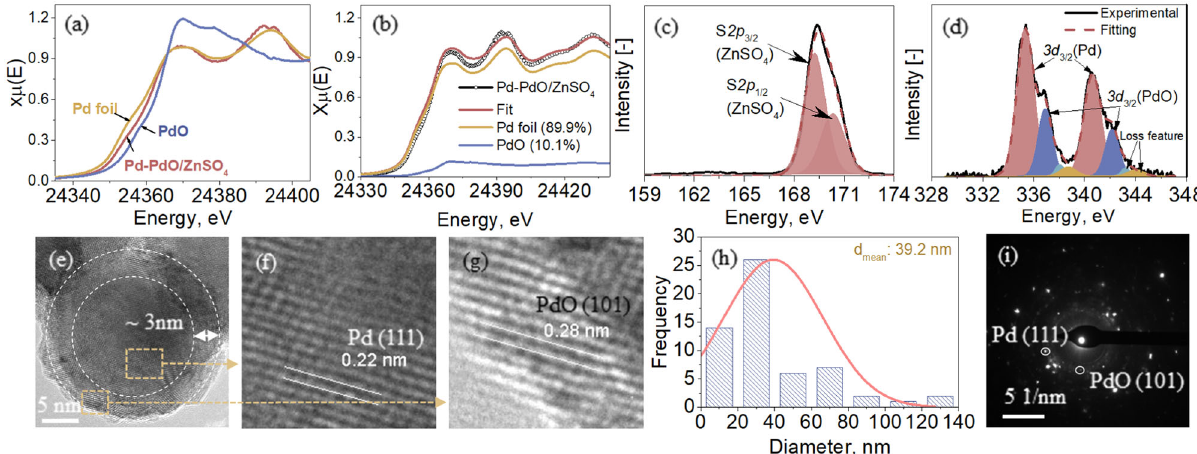
Fig. 2 | Characteristics of 1.1mol% Pd-doped ZnSO 4 catalyst. Panel a for Pd K-edge XANES spectra of the catalyst and two standards - Pd foil and PdO. Panel b for the linear combination fi tting (LCF) of the XANES spectra of the catalyst. Panels c and d for the XPS spectra of S 2p and Pd 3d , respectively. Panels e – g for the